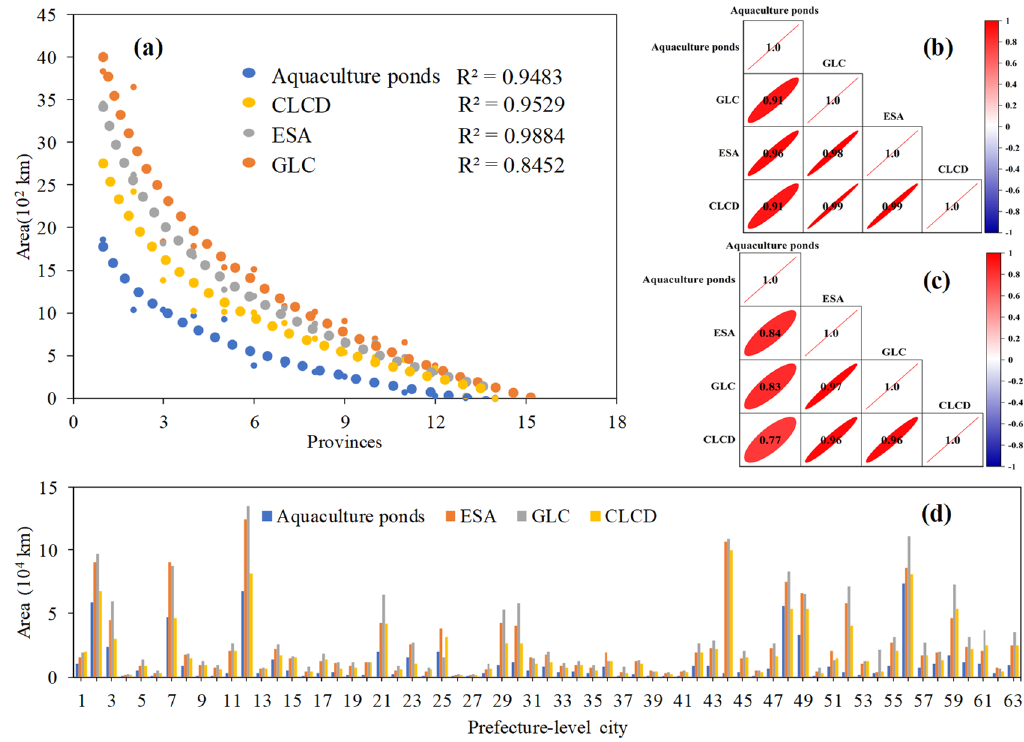
Figure 10. Statistics on the correlation between the aquaculture pond area and the water area of three land cover products in different provinces, cities, and counties. (a) Distribution of aquaculture ponds and water areas in provinces; (b) and (c) correlations between aquaculture ponds and water areas in provinces and prefecture ‐ level cities; and (d) distribution characteristics of aquaculture ponds and water areas in prefecture ‐ level cities.